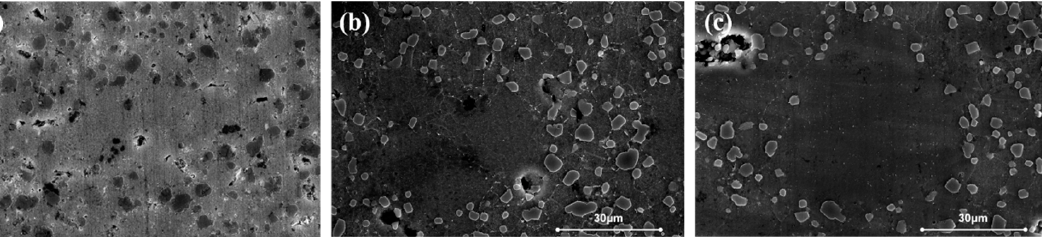
Figure 5. Microstructures of Al-7%Si-0.3%Mg-0.3%Cr-1.5%Cu alloy aged at 175 ℃ for ( a )1 h, ( b )12 h, ( c )16 h.